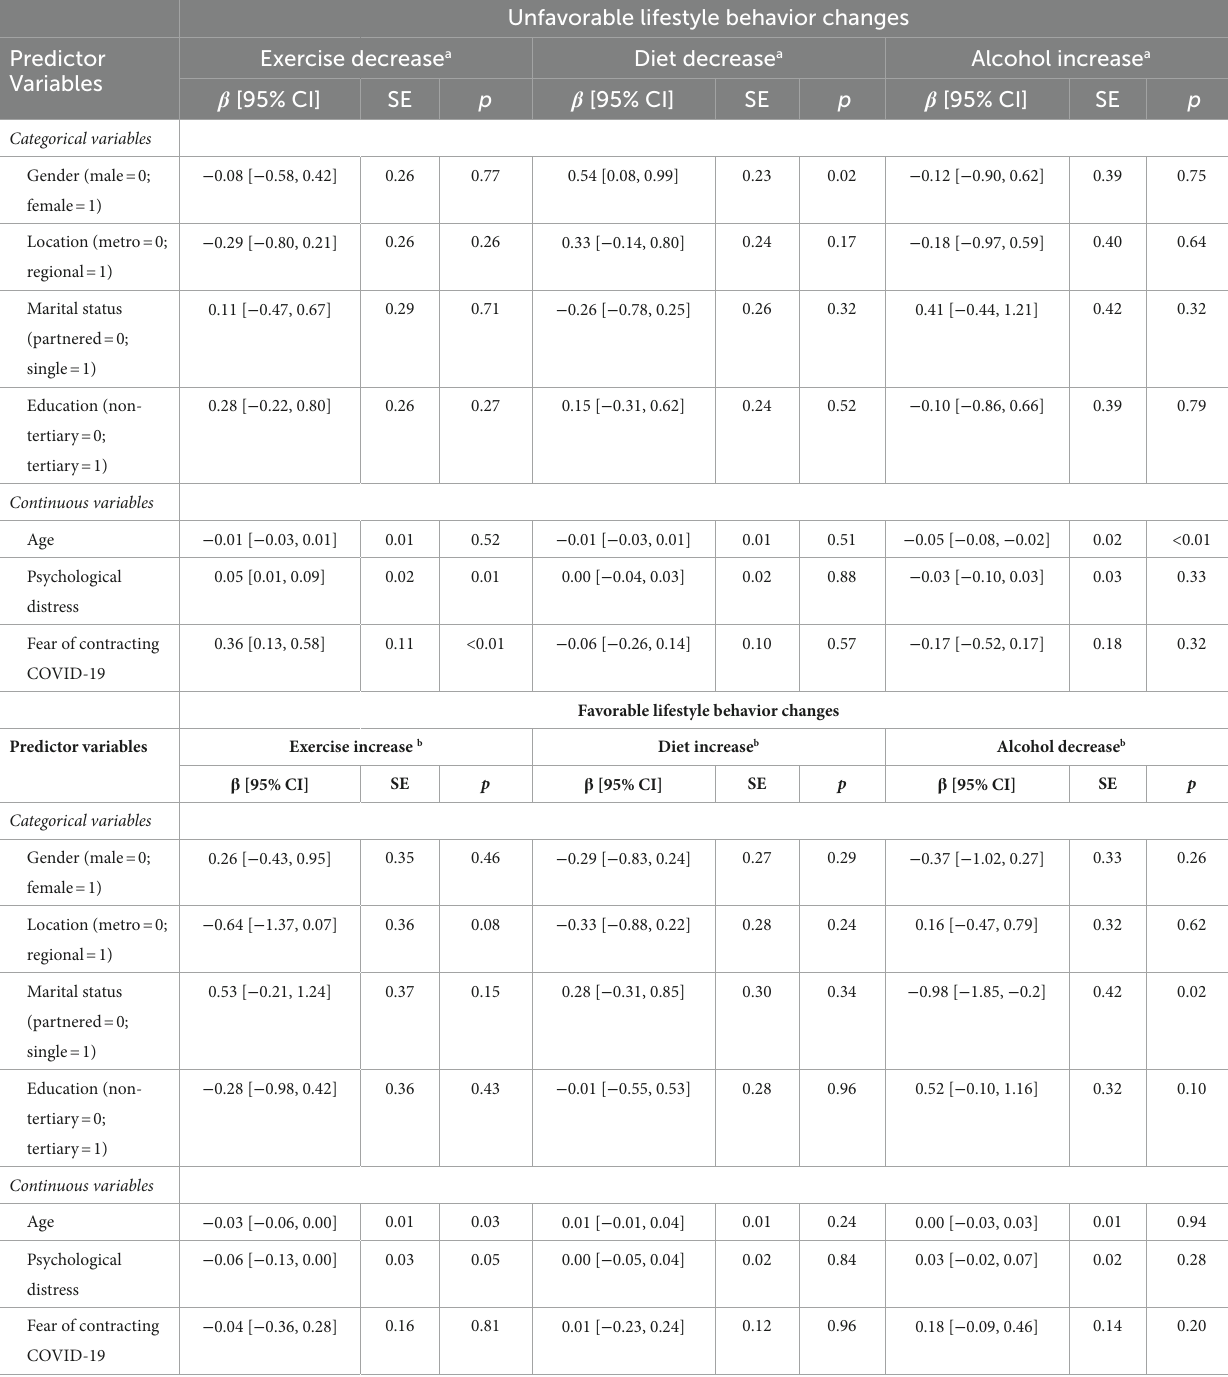
Unfavorable lifestyle behavior changes